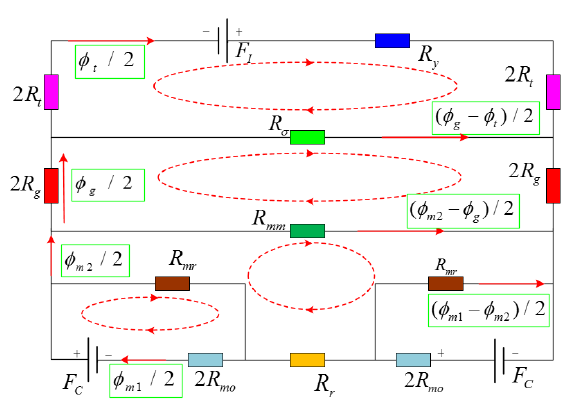
Figure 6. Equivalent magnetic network model.